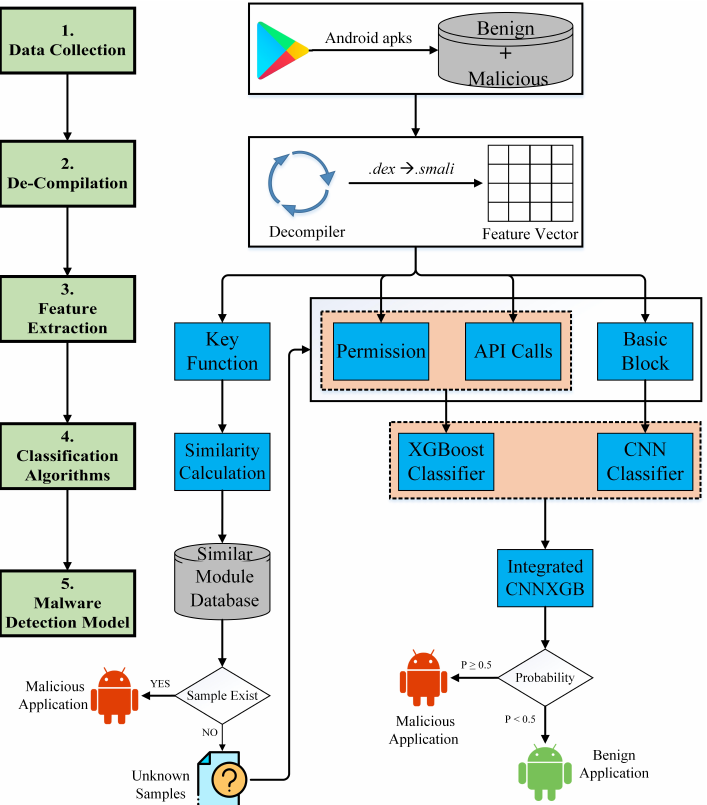
Figure 1. System Architecture of the Android malware detection using hierarchical authorization- sensitive